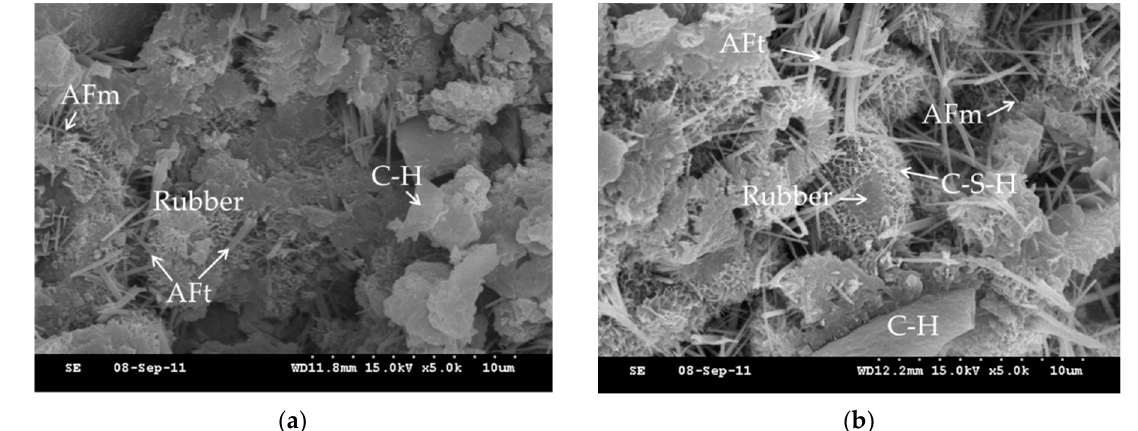
Figure 11. The SEM image of the additive to the cement ( a ) As-received rubber (5,000 × ), ( b ) treated rubber (5,000 × ).